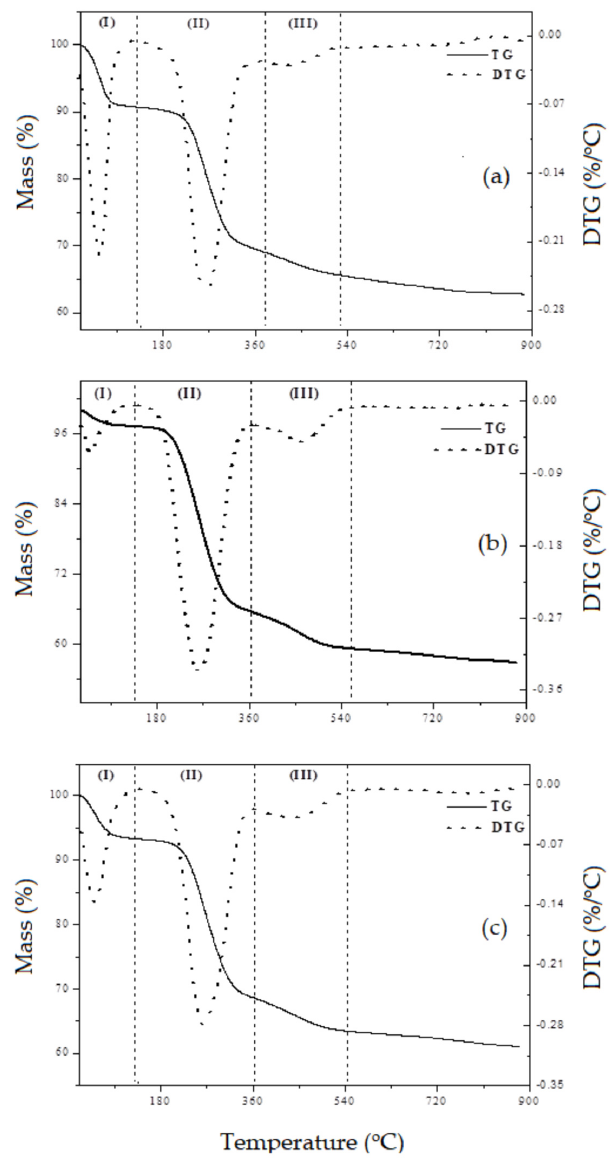
Figure 10. Thermogravimetry curves (TG/DTG) of the as synthesized materials: ( a ) SiO 2 ; ( b ) Ce–SiO 2 and ( c ) Lu–SiO 2 . Table 3. Thermogravimetric data for uncalcined SiO 2 and Ln–SiO 2